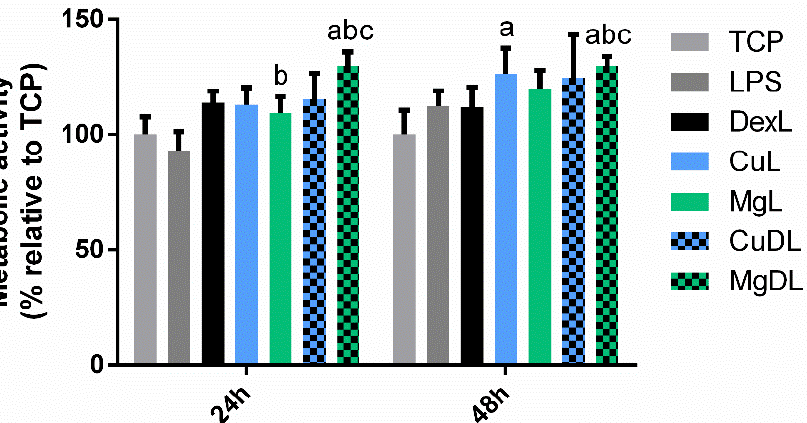
Figure 5. Effect of dex and the combination of dex with Cu 2+ (CuDL) and Mg 2+ (MgDL) on LPS- activated THP-1 cell metabolic activity. THP-1 cells were cultured with different dex and a combina- tion of dex with Cu 2+ and Mg 2+ (CuDL and MgDL, respectively) for 24 and 48 h. Metabolic activity results were represented as percentage relative to an unstimulated control (TCP) and compared with the TCP of each day. Statistically significant differences compared to TCP, LPS (10 ng/mL) and dex were indicated with a, b and c, respectively ( p < 0.05).